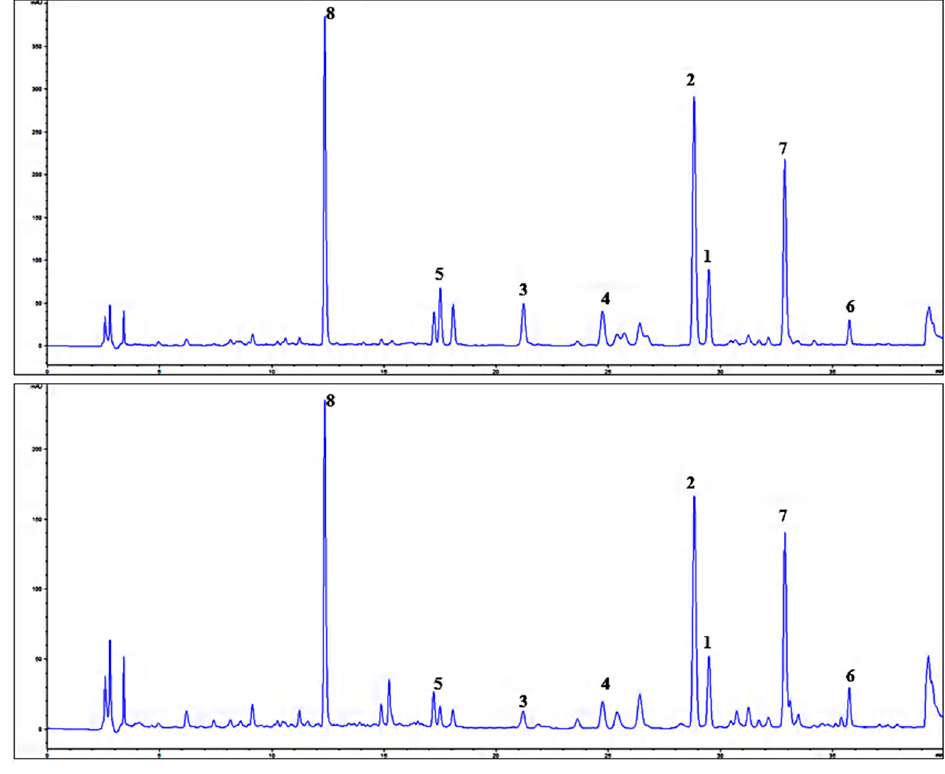
Figure 4. Chromatograms of S. latifolia (Ex. 1) and S. tomentosa (Ex. 3) aerial part extract; λ 254 nm; quercetin-3- O - β - D -glucoside ( 1 ), hyperoside ( 2 ), hydrangenol-8- O -glucoside ( 3 ), swertisin ( 4 ), 7-methylisoorientin ( 5 ), 3,5- O -dicaffeoyl-quinic acid ( 6 ), 4,5- O -dicaffeoyl-quinic acid ( 7 ), and chlorogenic acid ( 8 ).